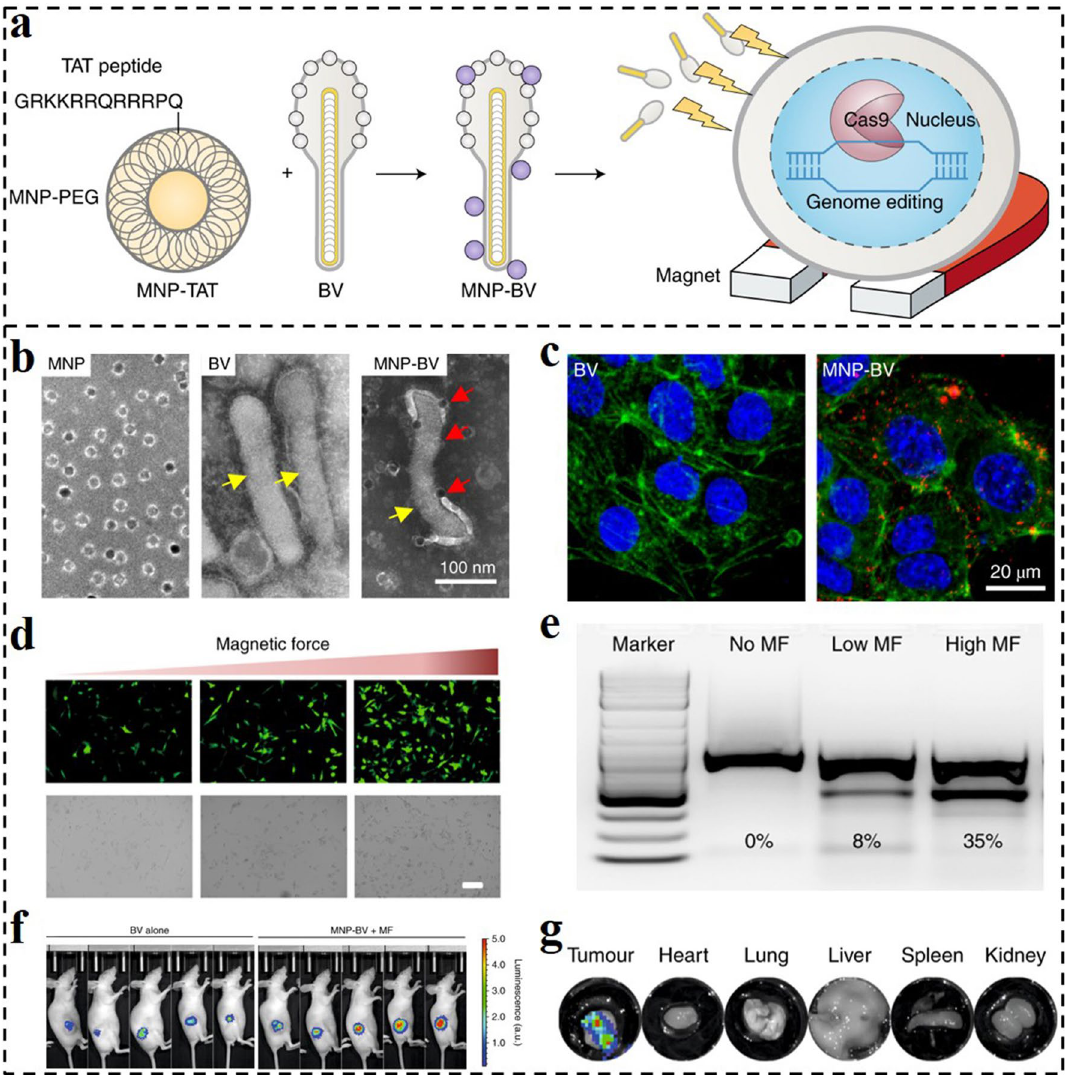
Fig. 17 a MNPs are coated with PEG, and conjugated with TAT to facilitate the interaction with BVs. An external MF improves the entry of MNP–BVs carrying the CRISPR–Cas9 system into cells [184]. Copyright 2019, Springer Nature. b TEM images of MNPs, BV and MNP-BV. c MNPs under external MF enhanced endocytosis of BV. d Transgene expression was examined by EGFP fluorescence at 24 h after transduction. e CRISPR-mediated VEGFR2 disruption correlated with the MF strength. f Bioluminescence analysis of transgene expression in the tumor at 24 h post-transduction. g Bioluminescence analysis of transgene expression in the dissected tumors and vital organs. b‑g Reproduced with permission from Ref. [137]. Copyright 2019, Springer